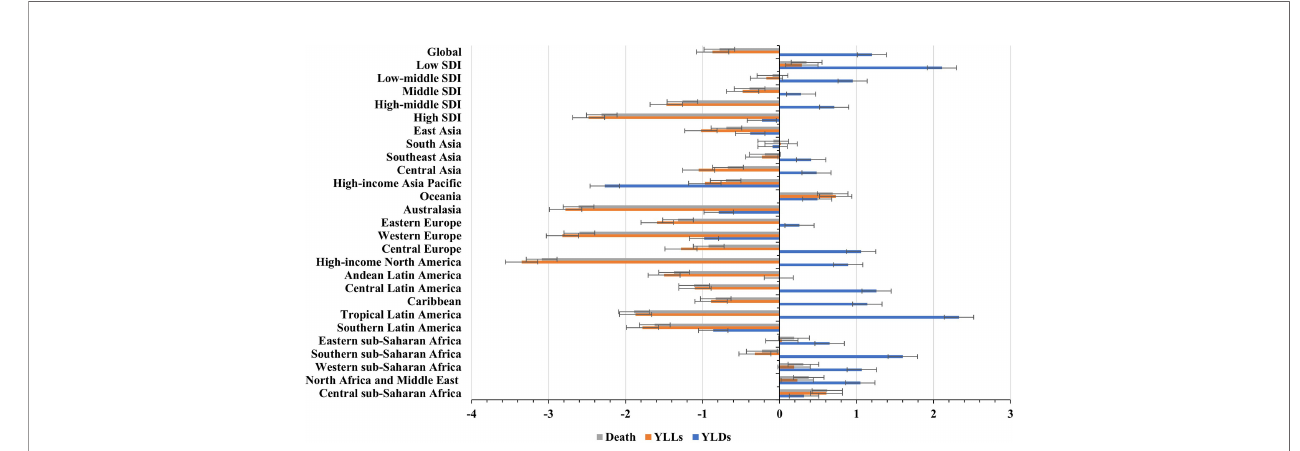
FIGURE 1 | Global trends in the ASR of death, YLLs, and YLDs caused by breast cancer attributable to secondhand smoke, and in SDI areas and geographic regions from 1990 to 2019. ASR, age-standardized rate; SDI, sociodemographic index; YLLs, years of life lost; YLDs, years lived with disability.